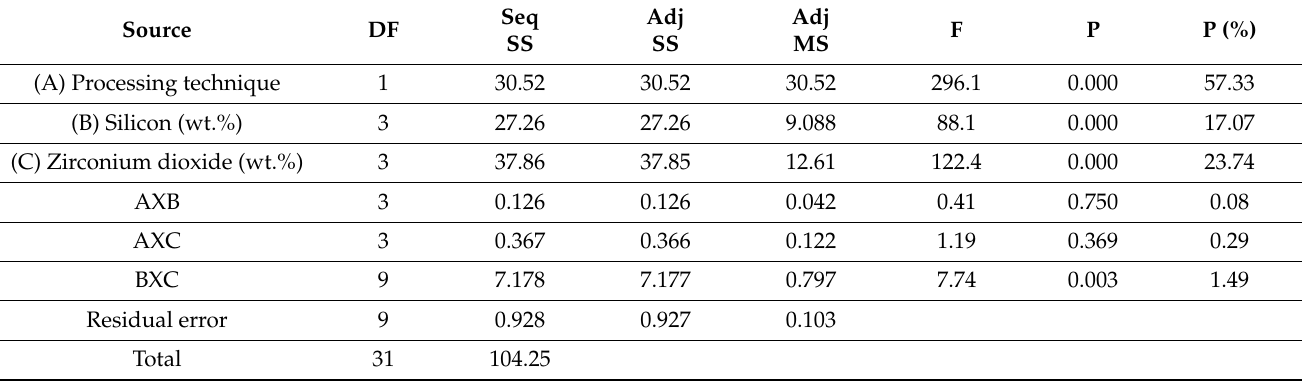
Table 8. ANOVA for SN ratios.